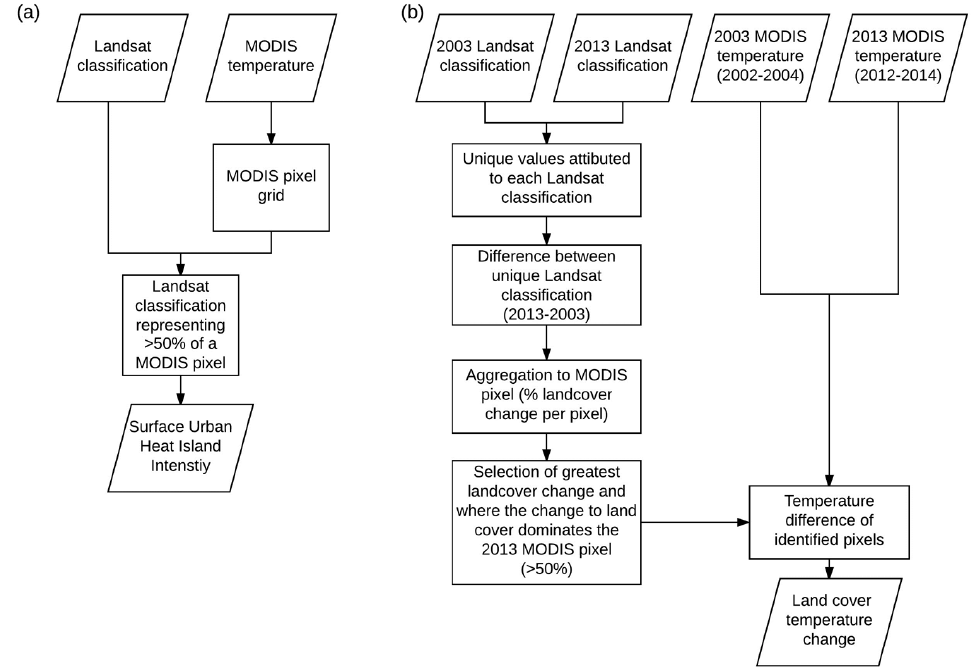
Figure 3. Summary of methodological procedures for: ( a ) SUHII and ( b ) land cover temperature change.